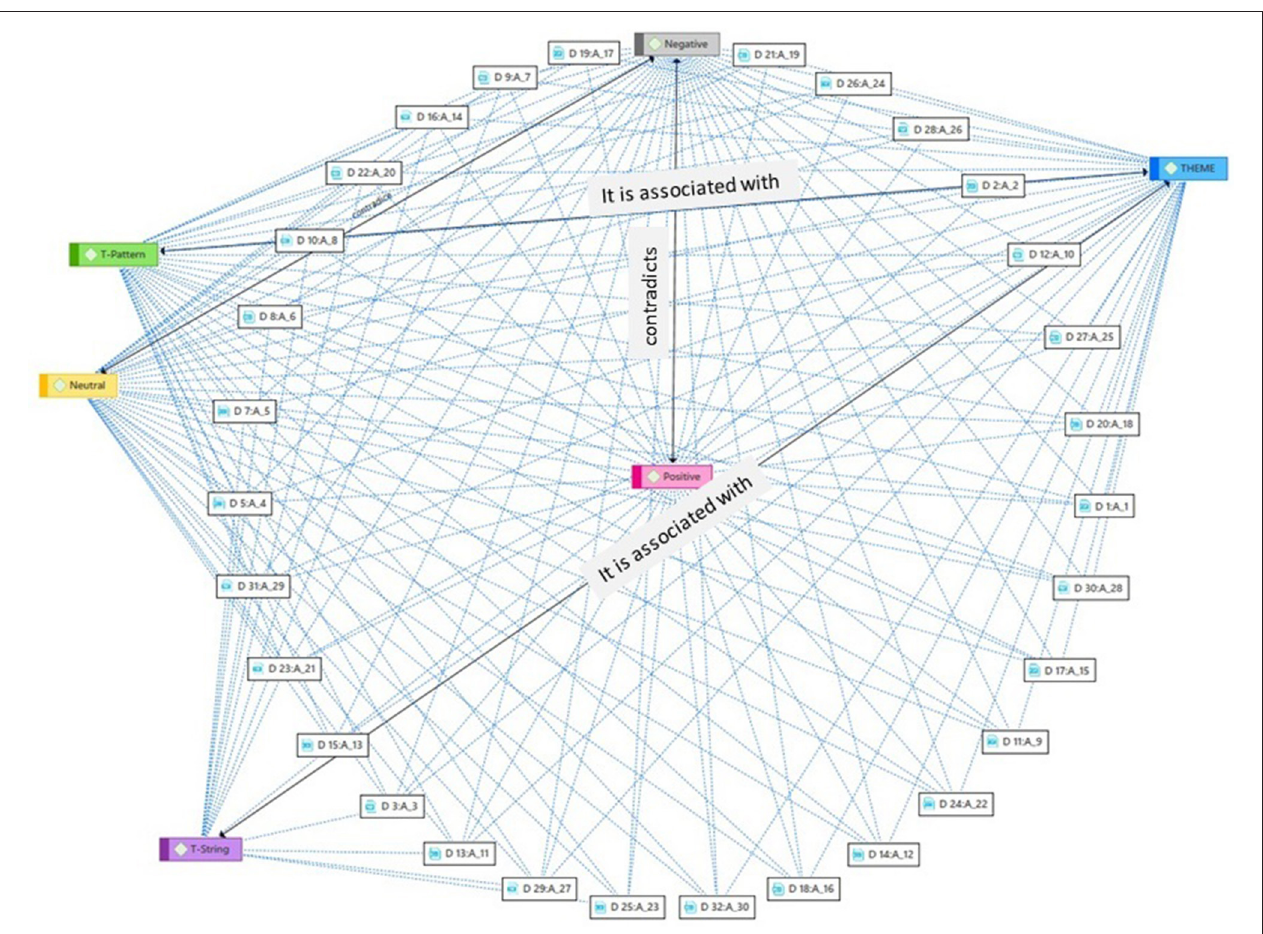
FIGURE 9 | Network analysis of documents and categorization